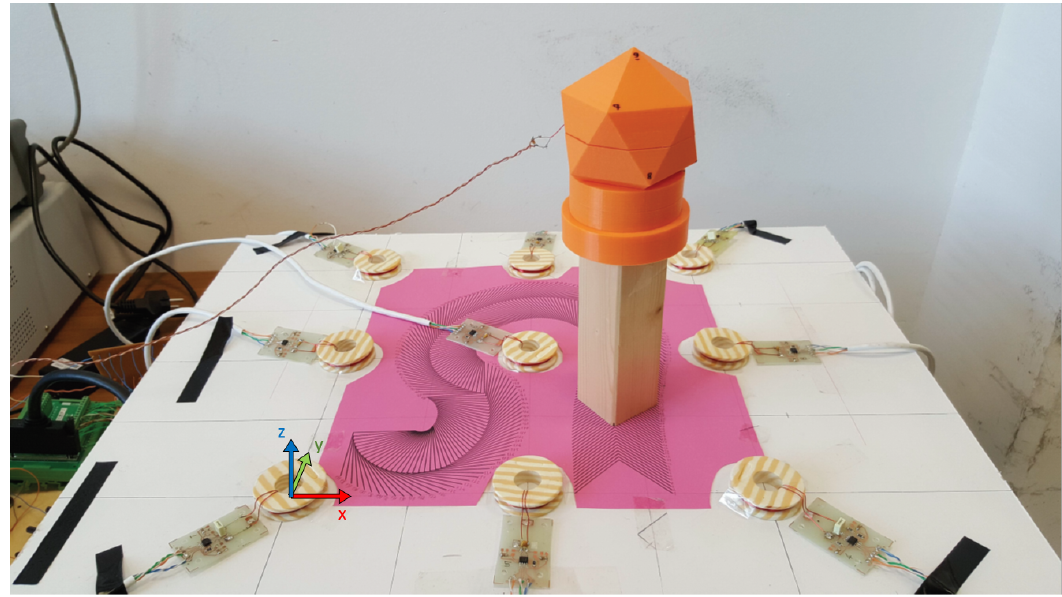
Figure 9. Hardware setup: nine sensing coils are placed on the xy plane shown at the bottom of the picture. Each of them is connected to a printed circuit board containing a parallel capacitor and an instrumentation amplifier. The field-generating coil is placed inside the icosahedral support shown at the top of the picture. The origin of the coordinate system is in the center of the coil shown at the bottom left of the picture, where a diagram of the axes of the coordinate system is also